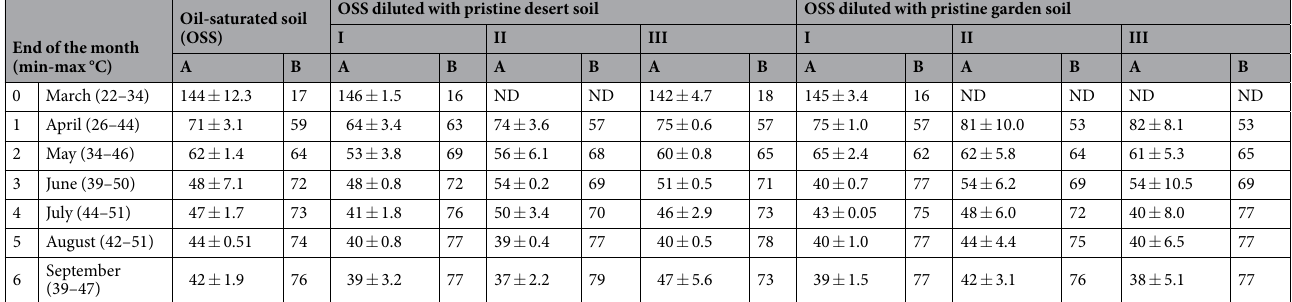
Table 1. Oil-consumption in oil-saturated desert soil (OSS) and OSS diluted to different degrees with pristine desert- and garden- soils. I, II and III; 1 kg OSS mixed with 0.25, 0.50 and 0.75 kg pristine soil, respectively; A, gram residual oil per heap (initial concentration, 173 g in all heaps) ± standard deviation values; B, % oil consumed based on the initial concentration; ND, not determined. Samples were taken at the ends of the adaptation month (0 March) and of the 6 subsequent